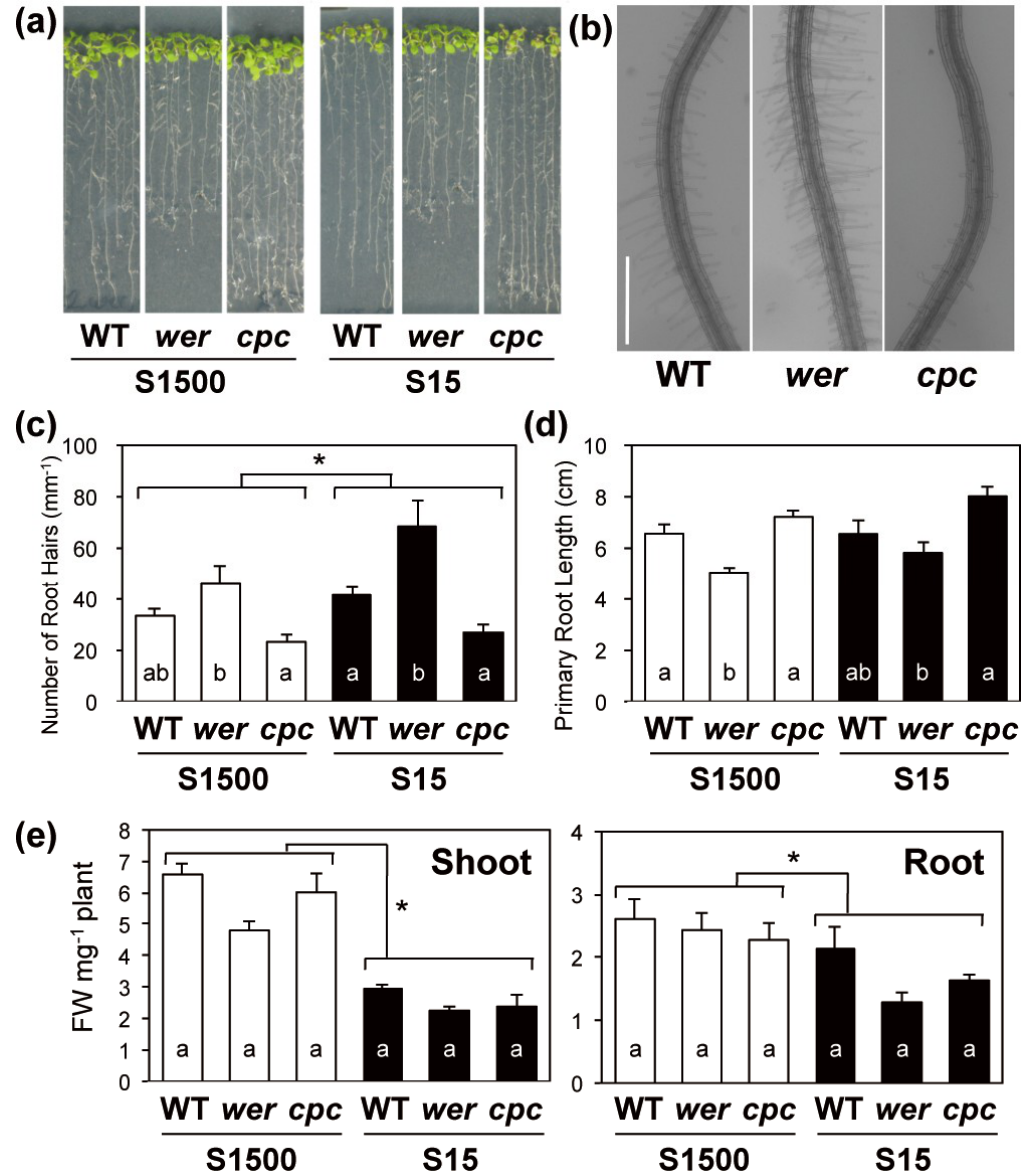
Figure 2. Plant growth and root development of wild-type (WT), and werwolf ( wer ), and caprice ( cpc ) mutants grown under sulfur-sufficient and -deficient conditions. Plants were vertically grown for 10 d on agar media supplied with 1500 µM sulfate (sulfur sufficient, S1500, white bar) or 15 µM sulfate (sulfur-deficient, S15, black bar). ( a ) Images of plants on their media. ( b ) Typical root image of plants grown under the S15 condition. Scale bar, 500 µm. ( c ) Number of root hairs in root elongation zone. Number of root hairs 5 mm from root tip was counted. ( d ) Primary root lengths. ( e ) Shoot and root fresh weights (FW) per plant. Values and error bars indicate means ± SEM [n = 5 in ( c ), n = 8 to 12 in ( d ), and n = 3 in ( e )]. Two-way ANOVA was used to detect the effects of sulfur conditions, genotypes, and their interactions. Asterisks indicate significant differences between the S1500 and S15 conditions (two-way analysis of vatiance [ANOVA], * P < 0.05) . As all comparisons in ( c – e ) did not detect interaction, the Tukey–Kramer test was used to analyze significant differences among mutants and the WT under the same growth condition. Different letters indicate significant differences ( P < 0.05).